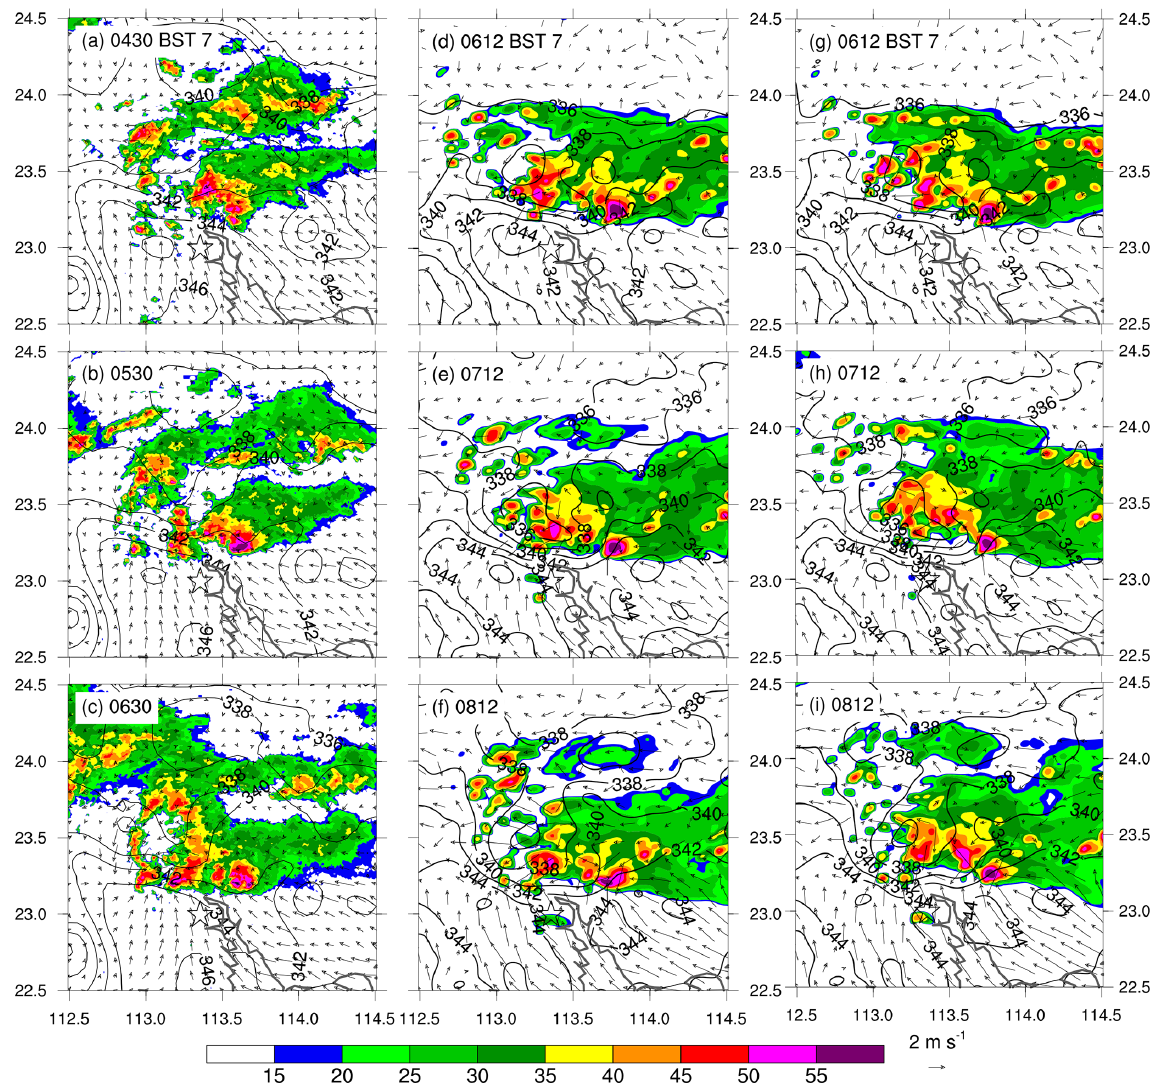
Figure 5. Horizontal maps of composite radar reflectivity (dBZ; shadings) and surface ( z = 10m) horizontal wind vectors and equivalent potential temperature ( θ e ; contoured at 2K intervals) during the extreme rainfall stage: (a–c) observed, (d–f) simulated with the EN scheme, and (g–i) simulated with the BR scheme. A reference wind vector is given beneath the right column next to the composite radar reflectivity colour